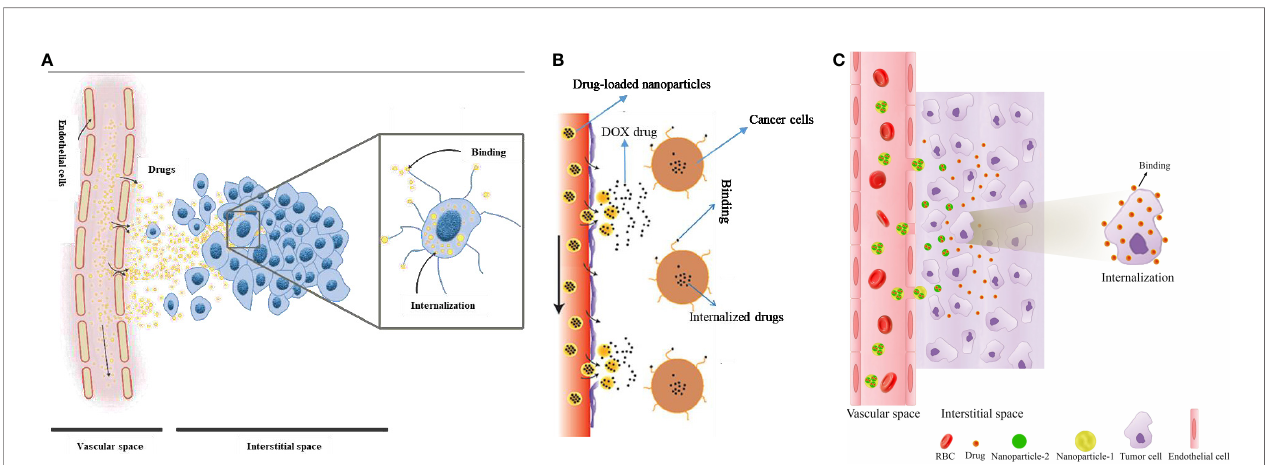
FIGURE 1 | Schematic of drug delivery mechanisms considered in the current study. (A) one-stage DDS or conventional chemotherapeutic delivery, (B) two-stage DDS (i.e., NP delivery), and (C) three-stage